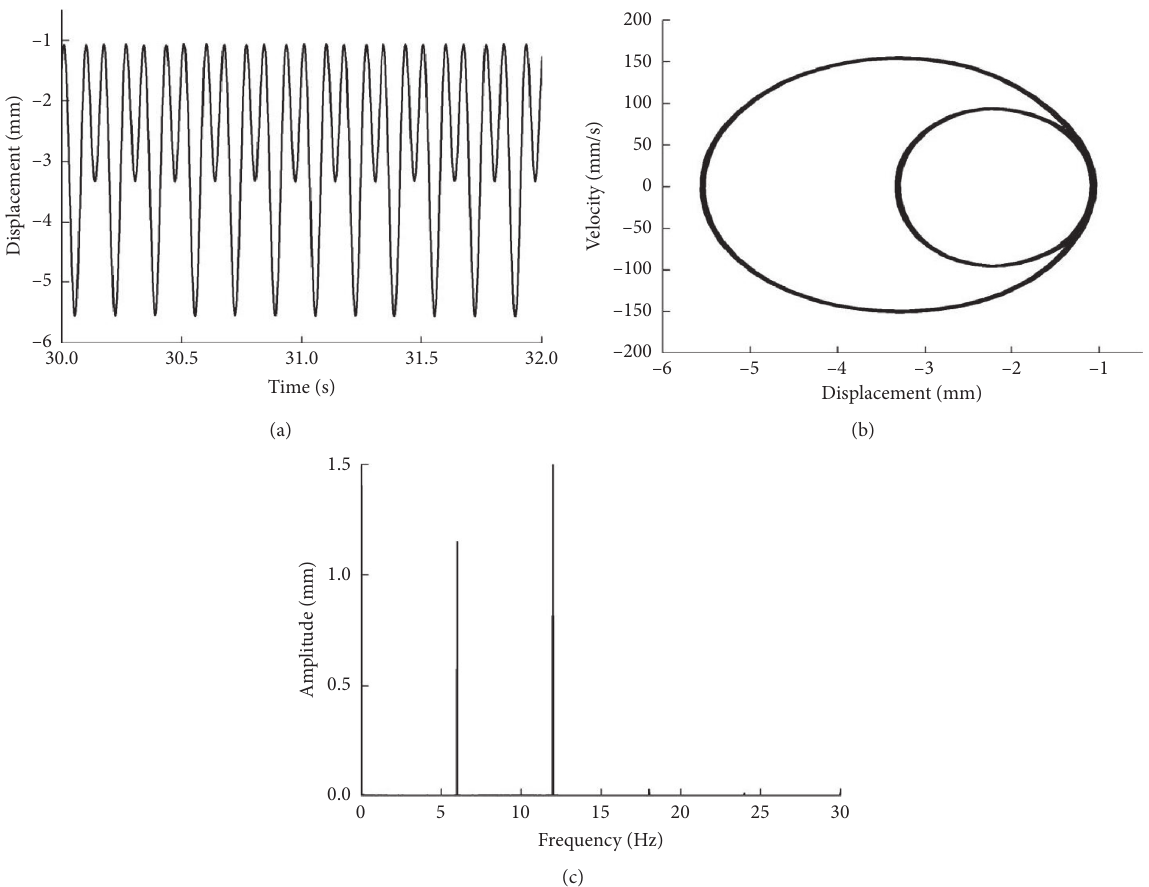
Figure 18: Period-2 motion of the system is obtained for the external excitation frequency Ω � 12Hz: (a) waveform; (b) phase portrait; (c) amplitude